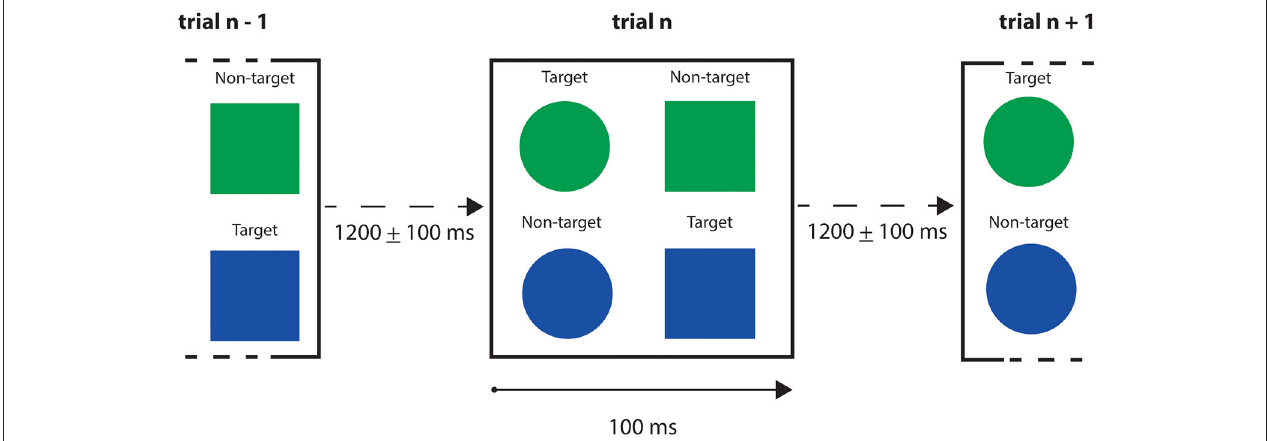
FIGURE 9 | Go/No-Go trials schematic representation. Trial’s exposition time for the stimuli was 100 ms, with a stimulus onset asynchrony (i.e., the time interval between two trials) between 1,100 and 1,300 ms. The stimuli presented were blue and green circles and squares. Participant was instructed to press a button when a blue square or a green circle appeared, and not to press for green squares and blue circles.